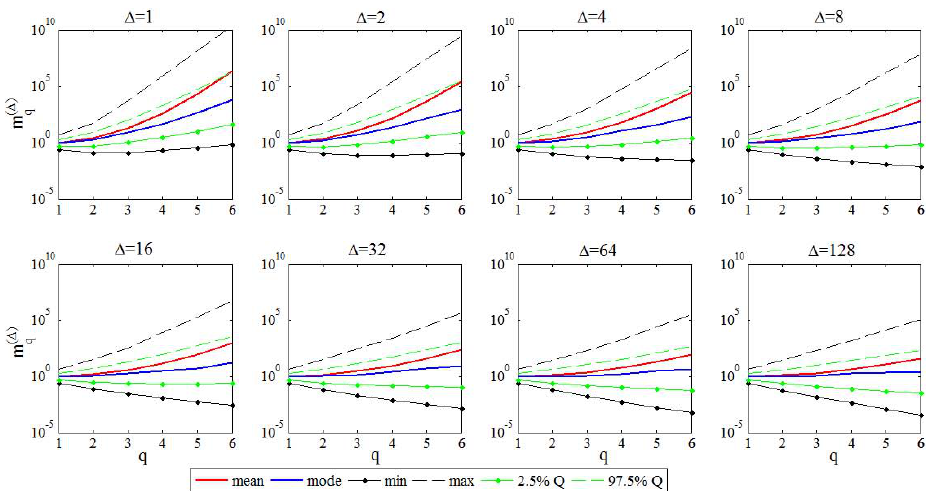
Fig. 5. Semi-logarithmic plots of the prediction intervals of the sample moments versus the order q for various timescales 1 , where “Q” stands for quantile.